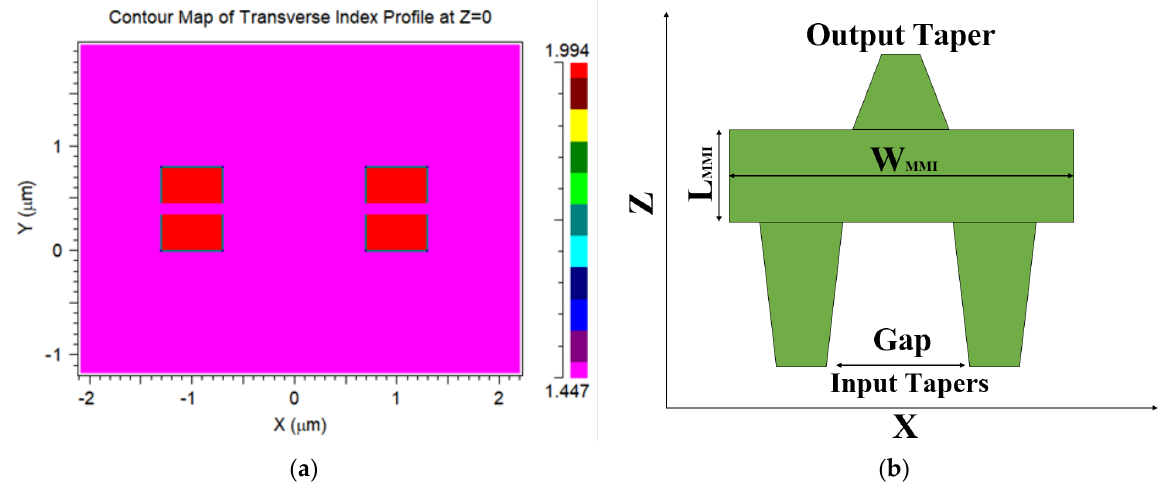
Figure 1. 2 × 1 power combiner structure design: ( a ) slot waveguide refractive index profile at the x-y plane; ( b ) full schematic sketch of the MMI coupler with the taper waveguides at the x-z plane.